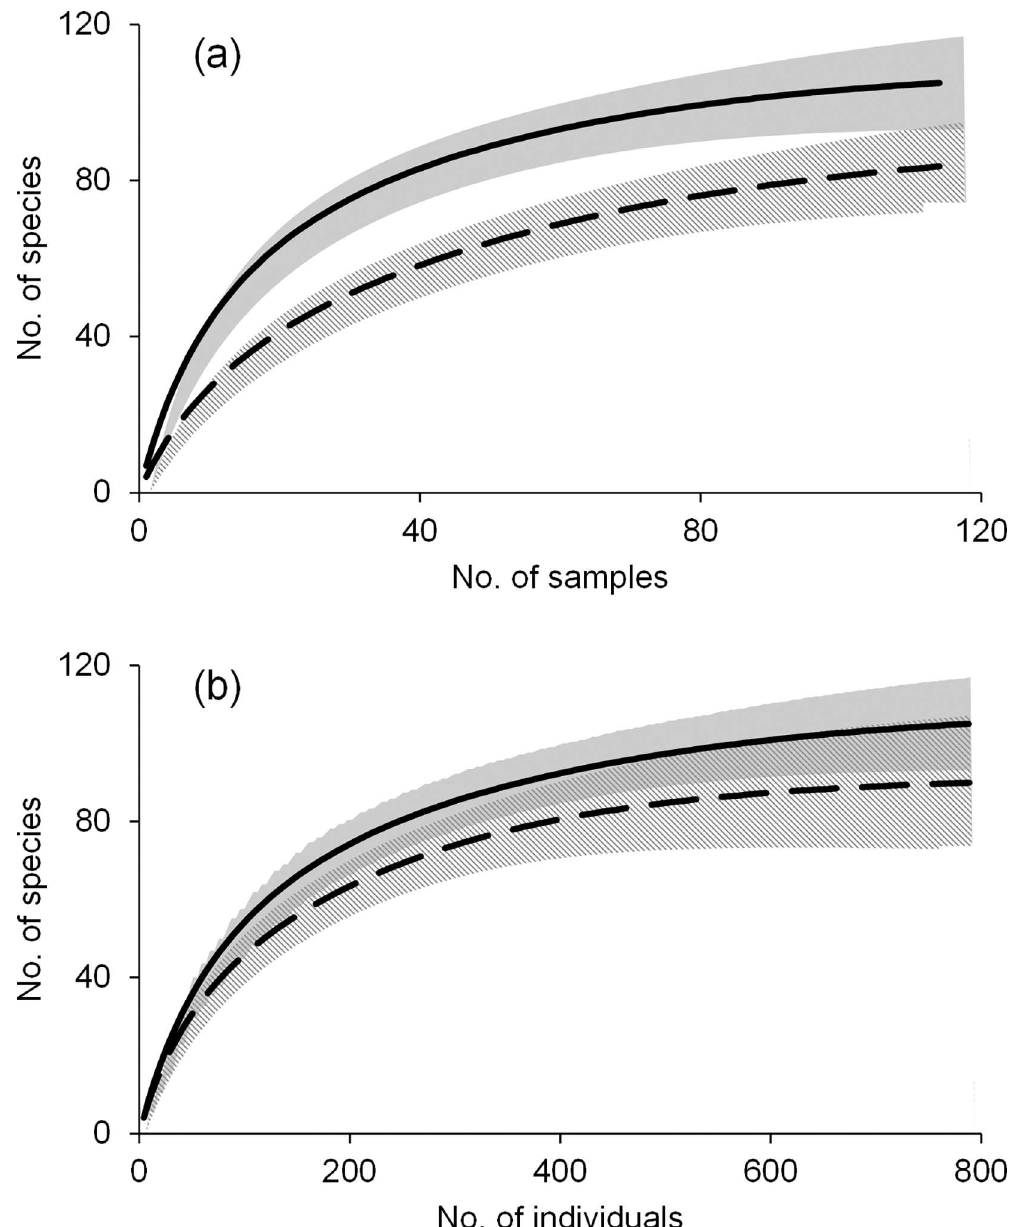
Fig 2. Speciesaccumulation curves. Sample-based (a) and individual-based (b) species accumulation curves illustratingsufficiency of sampling of hotspotand non-hotspot gridcells. Shadingindicates95% confidence intervals.Hotspotgrid cells = solid line and gray shading;Non-hotspot = dashed line and hashedshading.